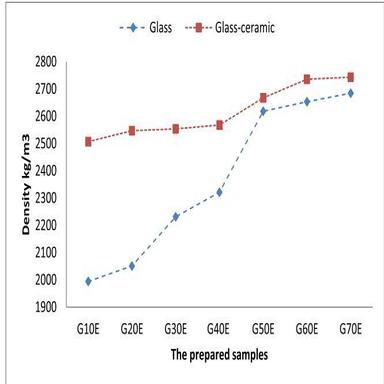
Density of glass and glass- ceramic samples after heat- treatment at 550◦C, 2h then at 800◦C, 2h.